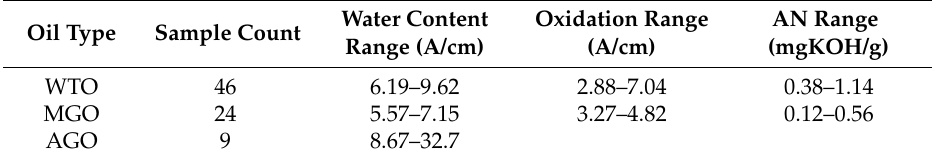
Table 1. Overview of the oil samples at our disposal. The samples of the wind turbine oil (WTO) and the marine gearbox oil (MGO) are aged in real applications, while the samples of the automotive gearbox oil (AGO) consist of fresh oil artificially contaminated with different concentrations of distilled